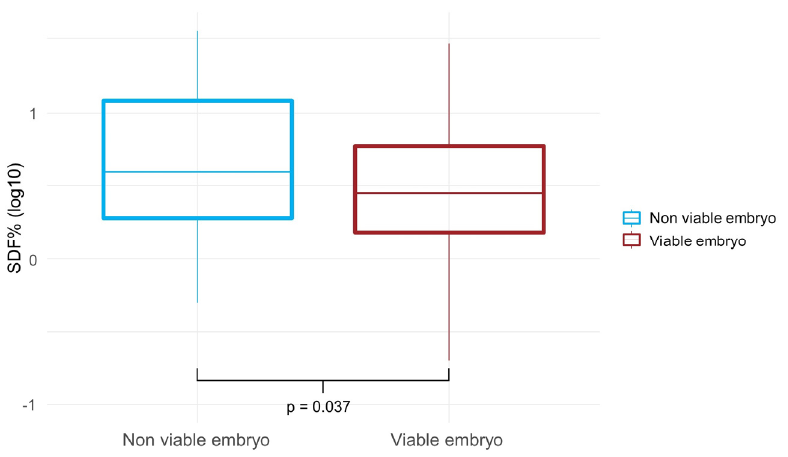
Figure 2. SDF post sperm selection procedures in semen samples according to the formation of a viable embryo ( p = 0.037). Table 5. Spearman correlations between SDF pre and post sperm selection procedures with ICSI outcome.